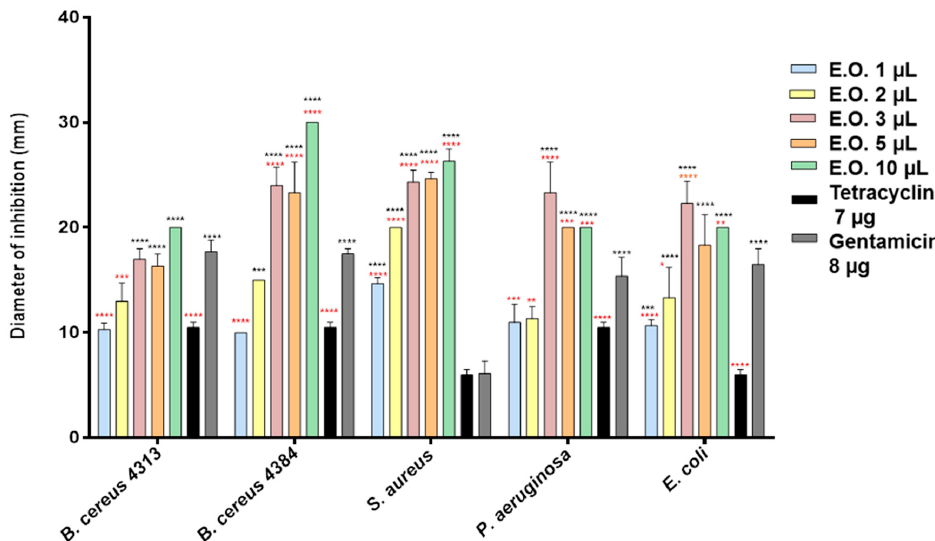
Figure 1. Antibacterial activity of essential oil (EO) of Citrus medica cv. ‘liscia’ and of the reference compounds, gentamicin and tetracycline. Results are the mean of three experiments. Dunnett’s test vs. gentamicin 8 μ g: **** p < 0.0001; *** p < 0.001; ** p < 0.01; * p < 0.05; Dunnett’s test vs. tetracycline 7 µ g: **** p < 0.0001; *** p < 0.001.